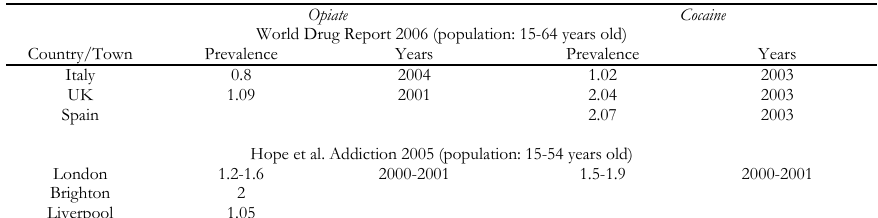
Estimated prevalence (x 1000) obtained in similar studies Opiate Cocaine World Drug Report 2006 (population: 15-64 years old)